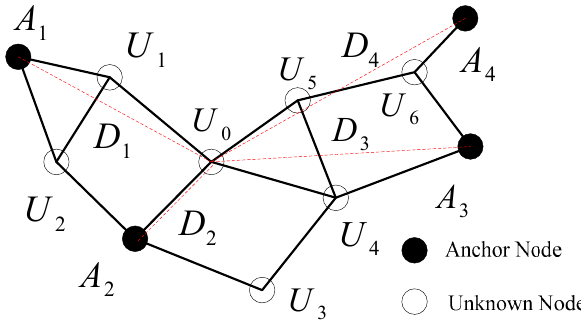
Figure 2. The schematic diagram of basic DV_Distance localization algorithm.